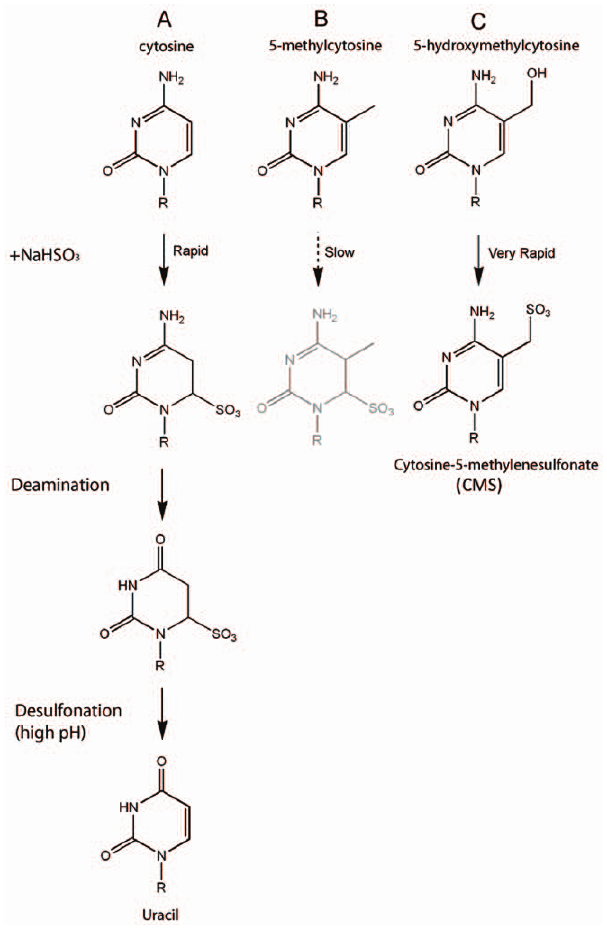
Figure 1. Reaction of sodium bisulfite with C, 5-mC and 5-hmC. (A) Bisulfite-mediated deamination of cytosine. HSO 3 2 reversibly and quickly adds across the 5,6 double bond of cytosine, promoting deamination at position 4 and conversion to 6-sulfonyluracil. 6- sulfonyluracil is stable under neutral conditions, but is easily desulfonated to uracil (U) at higher pH. (B) 5-methylcytosine is deaminated to thymine by bisulfite conversion, but the rate is approximately two orders of magnitude slower than that of cytosine. (C) Bisulfite quickly converts 5-hydroxymethylcytosine to form cytosine- 5-methylenesulfonate (CMS). This adduct does not readily undergo deamination [45].